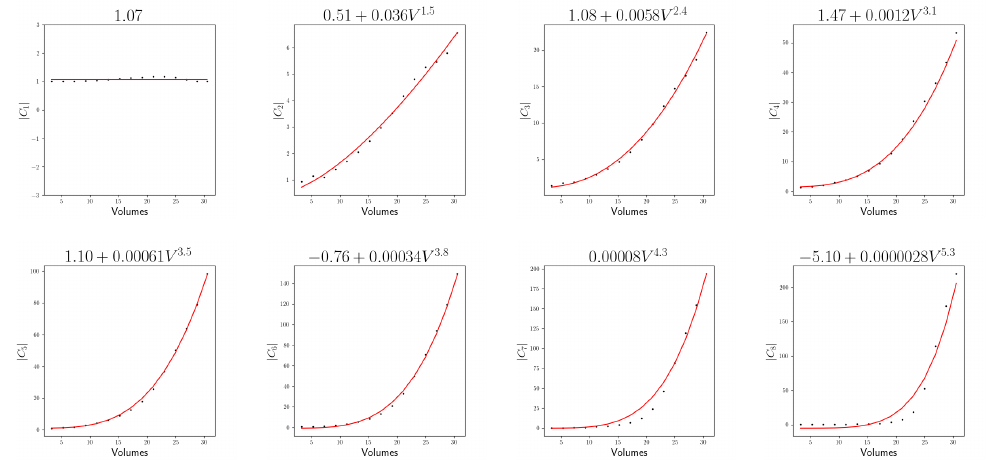
Figure 11 . The absolute values of the (first 8 ) Jones polynomial coefficients as a function of the hyperbolic volume. The coefficients obey a power law relationship with respect to the volume, where (for c i the i th coefficient) the constant coefficient decreases (by about an order of magnitude) and the exponent increases as i increases. These power law relationships are symmetric with the last 8 coefficients, as demonstrated in the table 2.